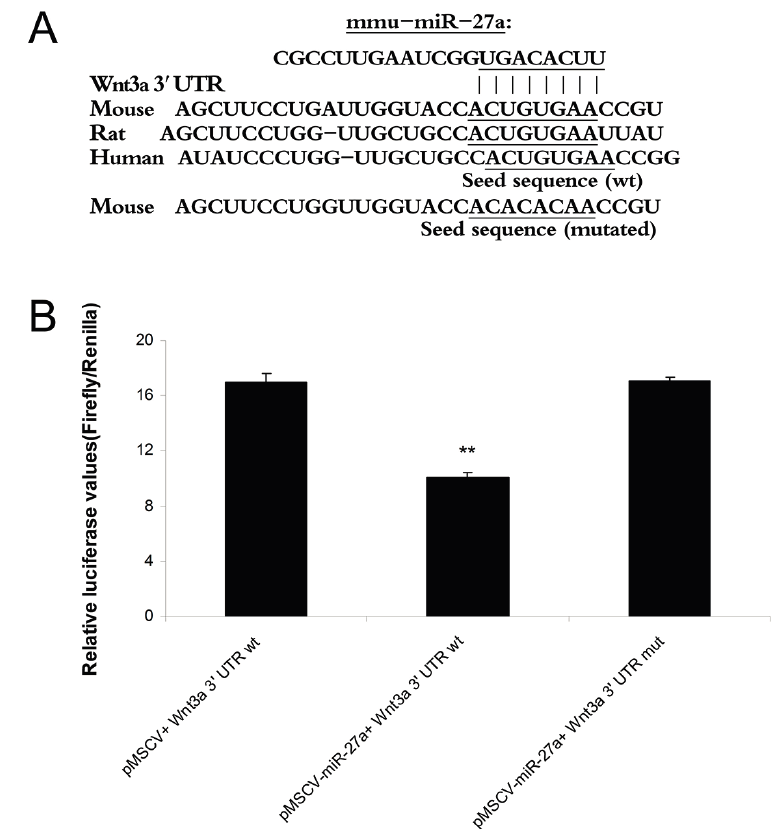
Figure 2. Wnt3a is a target of miR-27a-3p. ( A ) MiR-27a-3p binding site on the Wnt3a 3' UTR is shown, together with its homology across species; ( B ) Luciferase normalized to Renilla activity was measured in homogenates of HEK293T cells transfected with luciferase constructs containing the wild-type (wt) or mutated (mut) seed sequences of miR-27a-3p together with pMSCV-pre-miR-27a, or control pMSCV. Measurements were done 48 hours after transfection. The luciferase activity of cells co-transfected pGL0 Wnt3a 3' UTR (wt) with pMSCV-pre-miR-27a decreased 41%. ** p < 0.01. 2.3. Over-Expression of MiR-27a-3p in Melanocytes Inhibits the Expression of Wnt3a and β -Catenin To evaluate the effect of miR-27a-3p on the expression of endogenous Wnt3a in melanocytes, Wnt3a protein was stained using immunofluorescence in mouse melanocytes and cultured mouse melanocytes were transfected with miR-27a-3p mimic or inhibitor, and their negative controls. The result shows that Wnt3a protein is expressed in mouse melanocytes, mostly around the cell nucleus (data not shown). The treatment groups included control (untransfected), miR-NC (miR-27a-3p mimic negative control), miR-27a (miR-27a-3p mimic), inhi-NC (miR-27a-3p inhibitor negative control), and miR-27a inhi (miR-27a-3p inhibitor). Real time PCR analysis shows that expression of miR-27a-3p is significantly higher in miR-27a mimic transfected group compared to other groups ( p < 0.01). The expression of miR-27a-3p in miR-27a inhi group is significantly less than other groups ( p < 0.05) (Figure 3A). The results indicate that miR-27a-3p mimic, inhibitor and their NC can be transfected into melanocytes